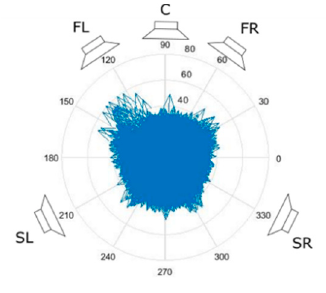
Figure 11. Sound intensity impulse response of a real room as source of spatial impulse responses for surround sound systems. (FL—front left; FR—front right; C—center; SL—surround left; SR—surround right).